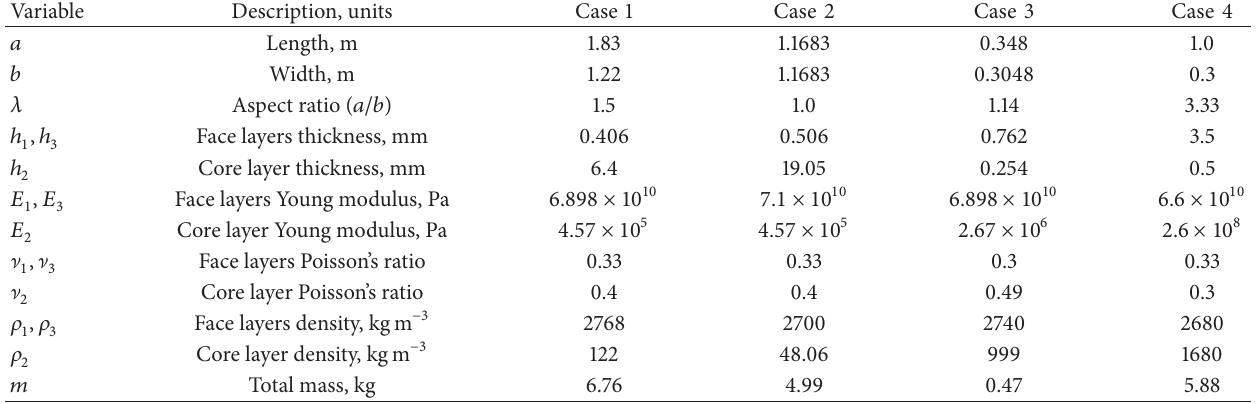
Table 1: Physical properties of composite panels.